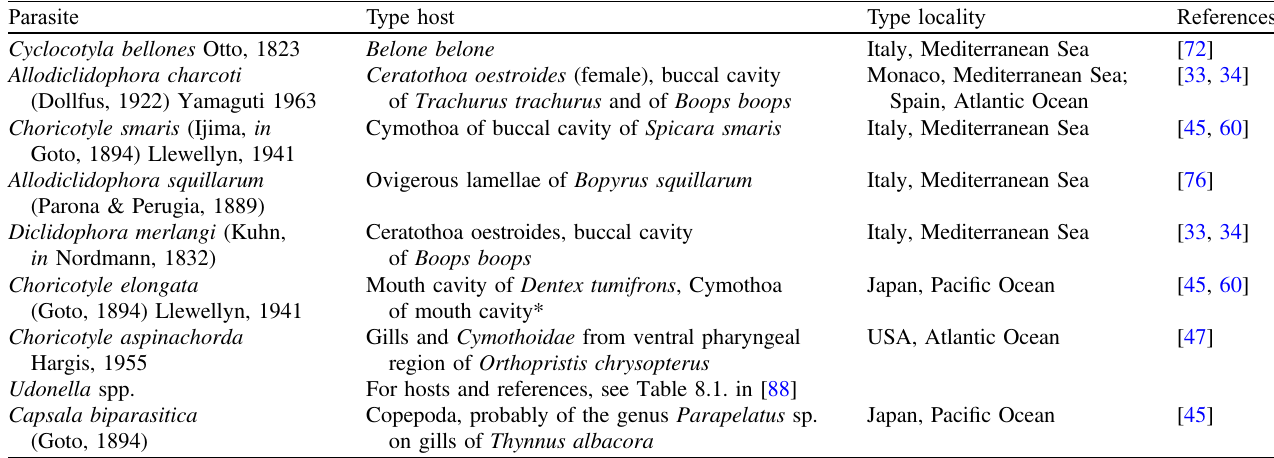
Table 1. Some hyperparasitic monogeneans on parasitic crustaceans.